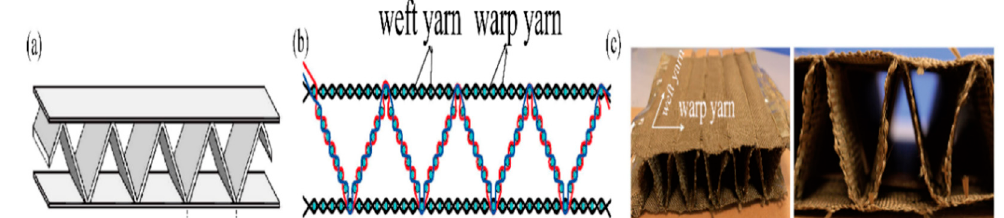
Figure 1. Different visual representations of zigzag-shaped spacer composites: ( a ) diagrammatic sketch; ( b ) cross-section; ( c ) real photograph. Table 1. Parameters of the zigzag-shaped 3D fabrics with three different